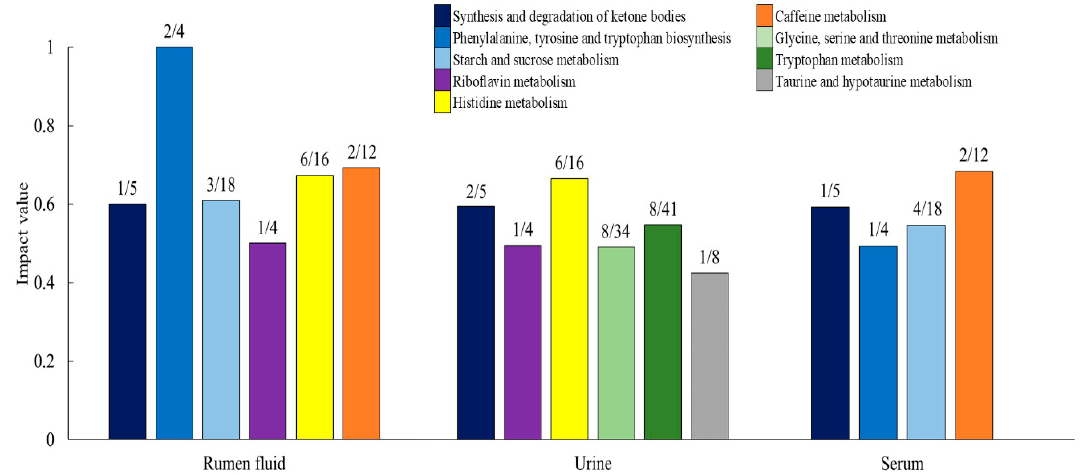
Figure 5. Metabolic pathways evidenced by enrichment analysis based on the metabolites common quantified in rumen fluid, serum, and urine (impact value ≥ 0.5). The x -axis represents the biofluid samples, and y -axis represents the impact value. The number on each bar graph is match status. Match status is hit / total. The total is the total number of compounds in the pathway; the hits is the actually matched number.